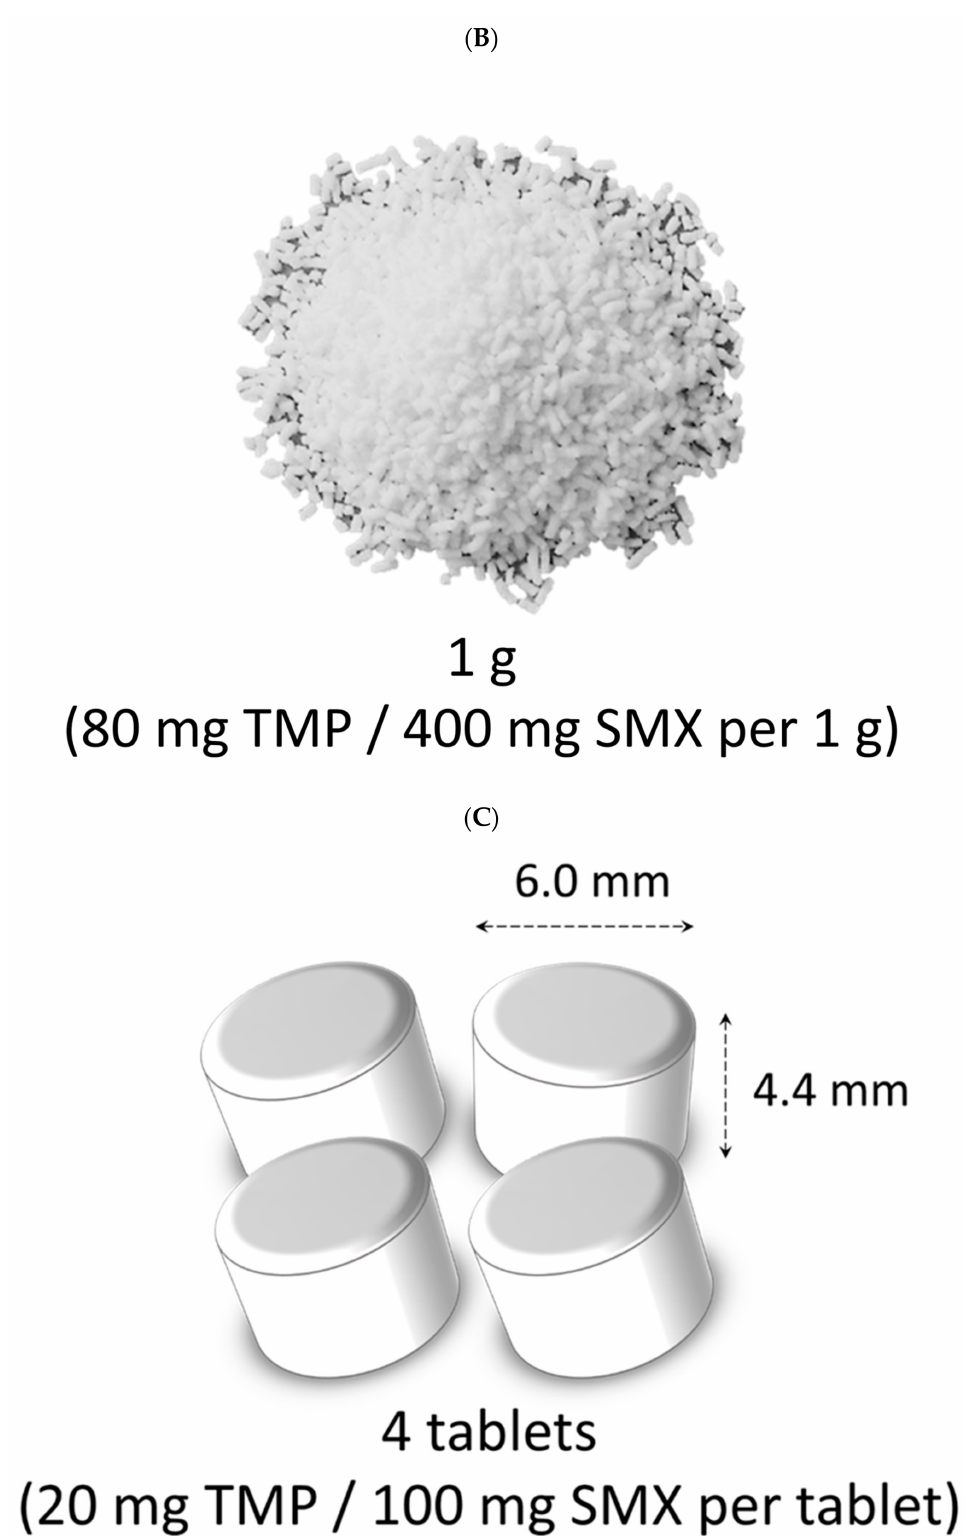
Figure 1. Sulfamethoxazole-trimethoprim combinations. Conventional tablet ( A ) contains 80 mg of trimethoprim (TMP) and 400 mg of sulfamethoxazole (SMX) per 1 tablet. Granules ( B ) contains 80 mg of TMP and 400 mg of SMX per 1 g. Small tablet contains 20 mg of TMP and 100 mg of SMX per 1 tablet. Small tablets ( C